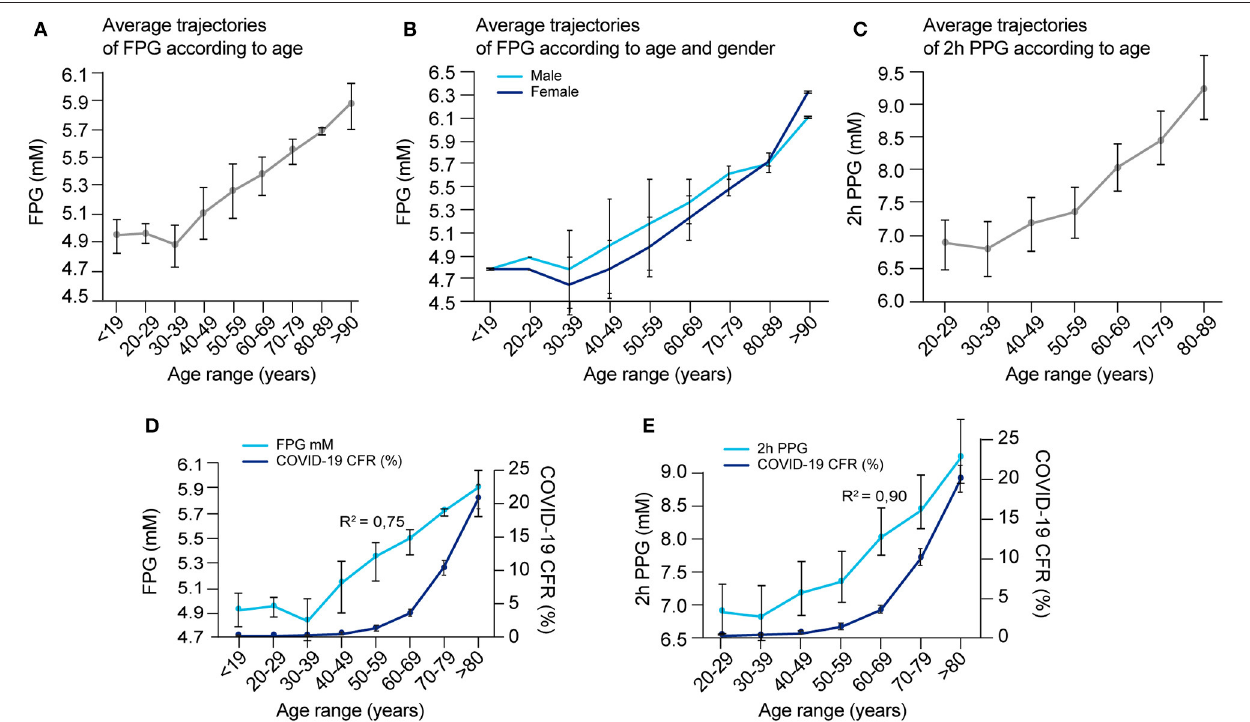
FIGURE 8 | Blood glucose concentrations according to age and gender and correlation with COVID-19 fatality. (A) Average FPG values per age range, (B) average FPG values per age range according to gender, and (C) average 2 h-PPG values after an OGTT test per age range were calculated according to raw data reported in several studies as detailed in Supplementary Table 5 , and reported. (D) Overlay of COVID-19 CFR and FPG in function of age ranges [from data reported in (A) and Supplementary Figure 1B ] and, (E) overlay of COVID-19 CFR and 2 h-PPG in function of age ranges [from data reported in (C) and Supplementary Figure 1B ] are represented to detect possible correlation in between these age-related events. The correlation coefficient “R” that indicates how strong is the relationship between the two variables is calculated between the two respective series of values for the same age range, then R 2 , the coefficient of determination = R ∧